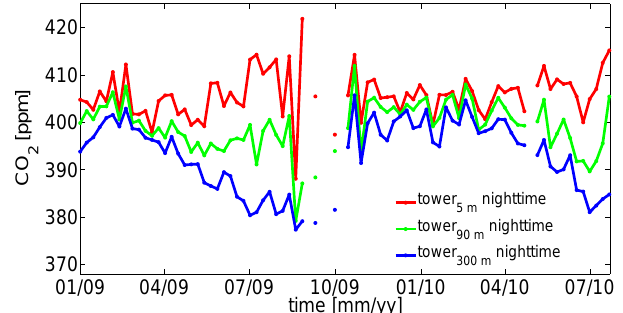
Fig. 6. The nocturnal CO 2 time series for three tall tower levels (5m, 90m, 300m) highlighting the seasonal cycle. The measure- ments are shown as weekly averages of nighttime measurements be- tween 00:00a . m . and 05:00a . m . LT. Gaps in the in situ data record are due to instrumental